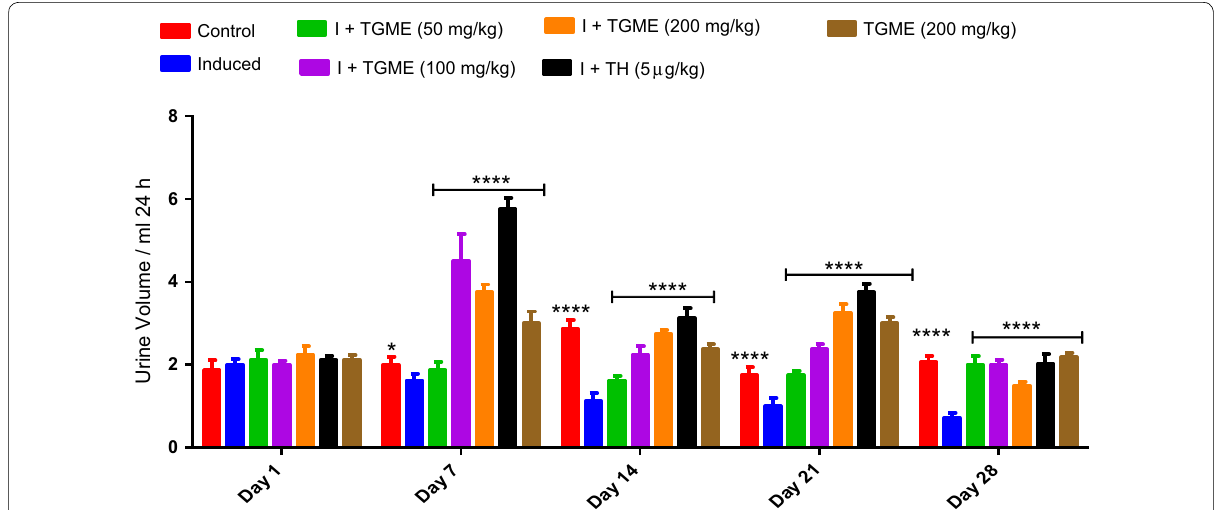
Fig. 4 Effect of aqueous methanolic leaf extract of Triclisia gilletii on urine volume/mL 24 h per week in animals administered ethane-1,2-diol. Data are expressed as mean SEM of 6 rats ( n 6); **** p < 0.0001; * denotes that data were compared with ethane-1,2-diol; TGME Triclisia gilletii aqueous ± = methanolic extract, TH tamsulosin hydrochloride